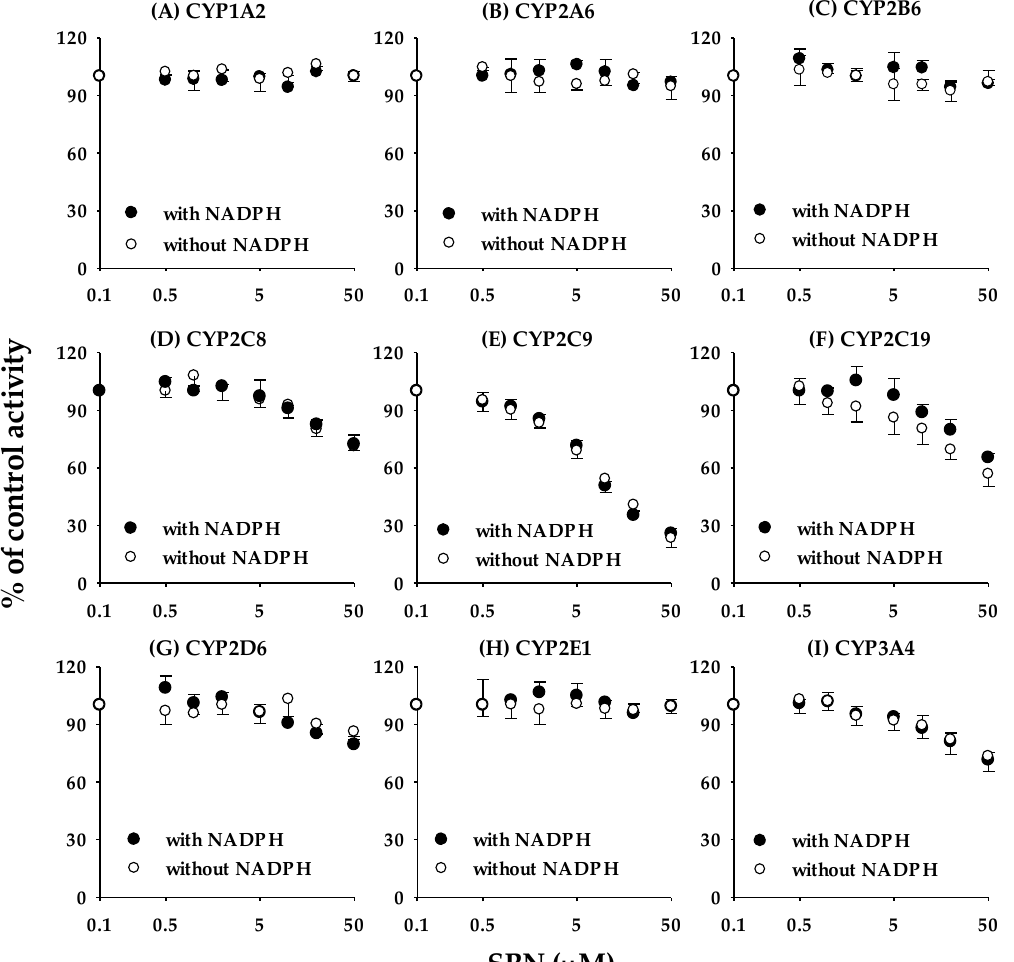
Figure 5. Time-dependent inhibition curves of SPN on the nine major P450 activities in human liver microsomes using substrate cocktails after 30 min pre-incubation with the presence ( • ) or absence ( ○ ) of an NADPH-generating system. Data are the mean ± standard deviation of triplicate incubations.